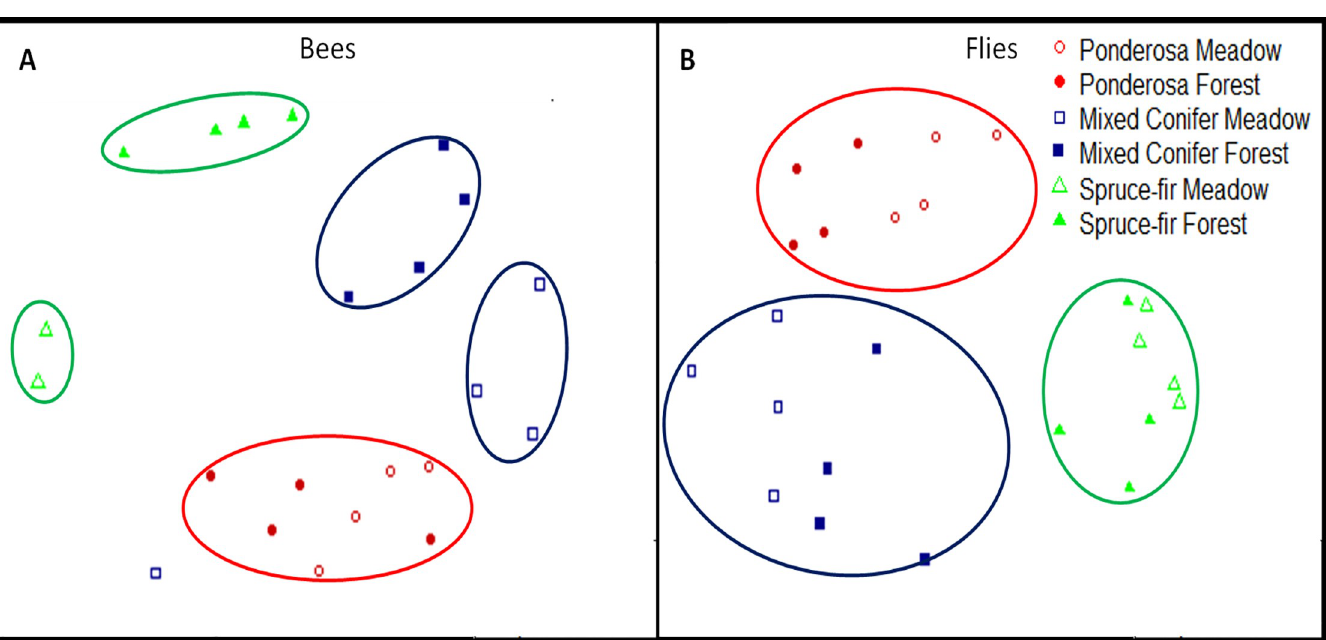
Fig 3. Non-metric multidimensional scaling ordination (NMDS) comparison of bees (A) and flies (B) between forest versus meadow habitats at each of the three elevation vegetation types. Bees (A): all elevations were distinct (p < 0.05) from one another, but meadow and forest habitats were not different in community composition between the three elevation zones; ponderosa (p = 0.0587), mixed conifer (p = 0.1148) and spruce-fir (p = 0.0778). Flies (B): Fly community composition was distinct among the three elevation zones (ponderosa (p = 0.0435), mixed conifer (p = 0.0.030) and spruce-fir (p < 0.0001)), but not between forest and meadow habitat (p < 0.05). Ellipses in graph represent non-significant point groupings (i.e. paired MRPPS between points were less than 0.05).